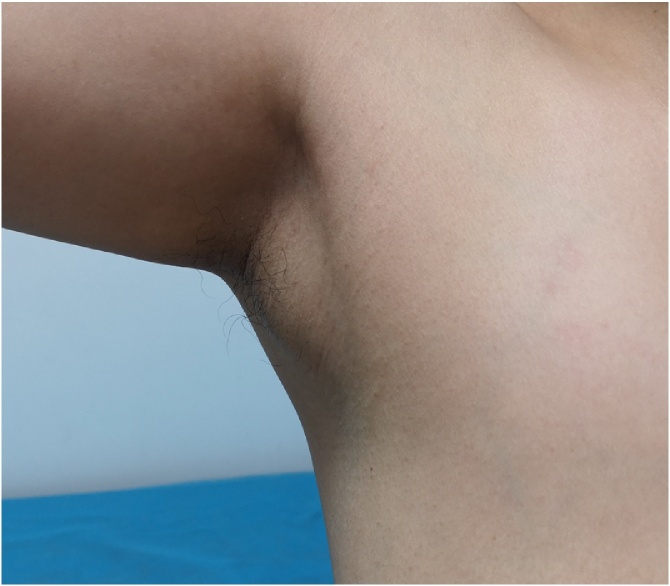
Accessory breast.